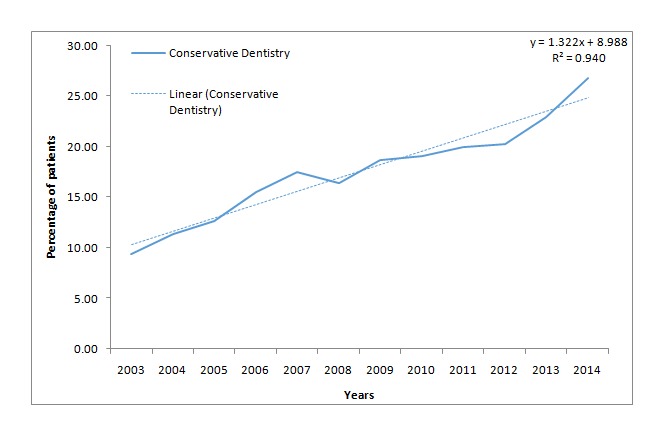
Graph 5: Trend line showing variation of referrals to conservative dentistry department.